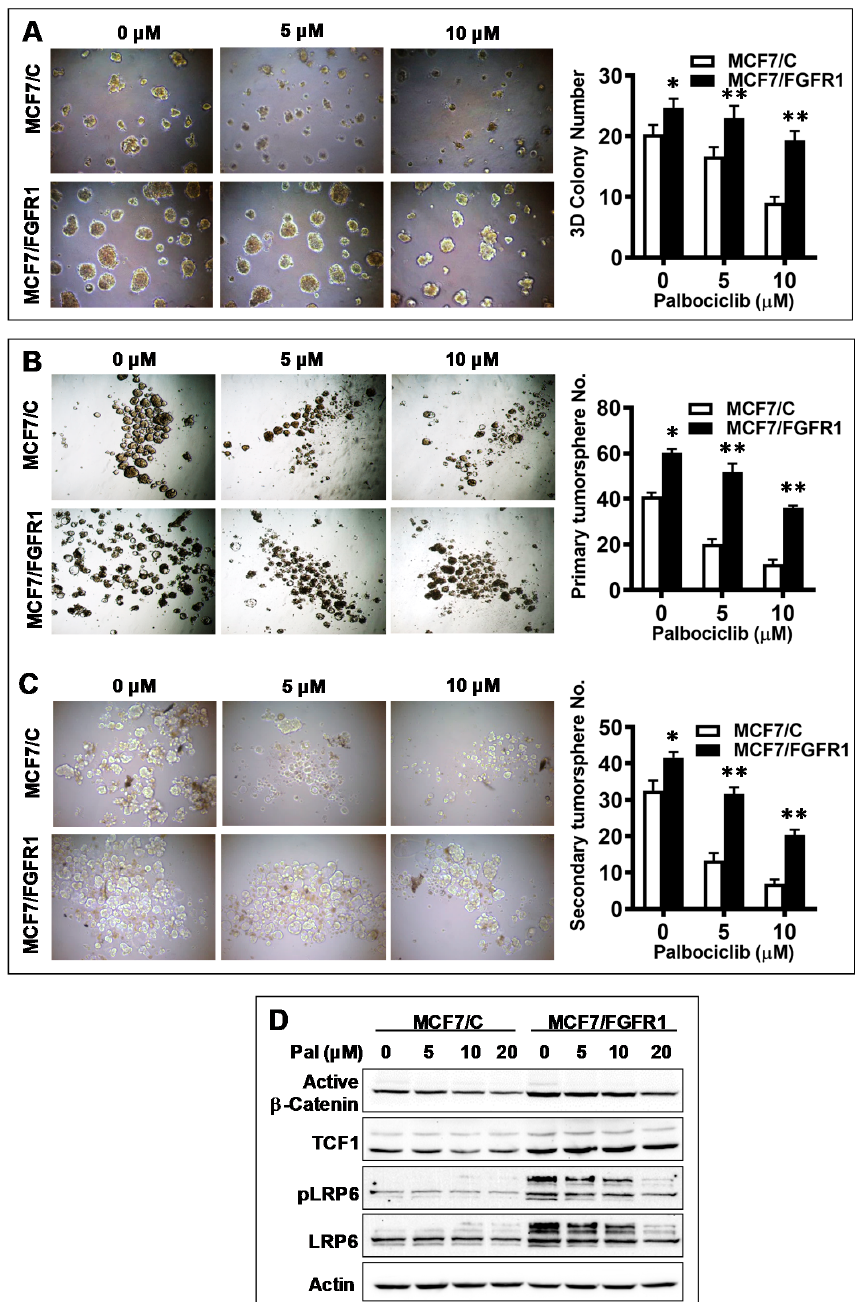
Figure 3. FGFR1 overexpression induces CSC stemness in palbociclib-treated MCF-7 cells. ( A ) Evaluation of anchorage-independent growth in palbociclib-treated MCF-7/C and MCF-7/FGFR1 cells with 3D culture. The cells cultured in matrigel were treated with palbociclib (0, 5, 10 μ M) for 7 days, followed by colony imaging and analysis. ( B , C ) Tumorsphere assays of palbociclib-treated MCF-7/C and MCF-7/FGFR1 cells. The cells were plated in ultra-low attachment plates and treated with palbociclib (0, 5, 10 μ M) for 7 days in triplicate. Primary tumorspheres ( B ) were imaged and counted for analysis. Single-cell suspensions, harvested from corresponding primary spheres, were then replated for secondary sphere formation ( C ) and analysis. ( D ) Western blot detection of markers in Wnt signaling. MCF-7/C and MCF-7/FGFR1 cells were treated with palbociclib at indicated concentrations for 48 h, followed by Western blot analysis of specified markers. Data in ( A – C ) were analyzed by Student’s t -test (** p < 0.01, * p < 0.05 vs. corresponding control cells).